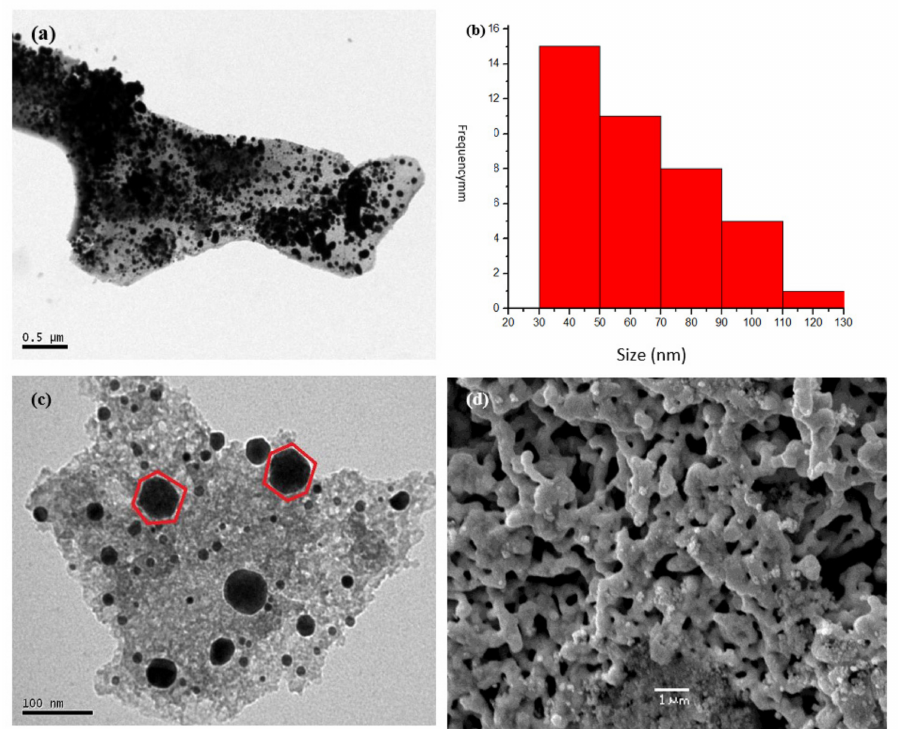
Figure 11. TEM image ( a ), particle size histogram, ( b ), TEM image in a magnified area ( c ), and an SEM image ( d ) for the pyrolytic products from the PS-co-4-PVP · (PtCl 2 ) n precursors. Adapted from reference